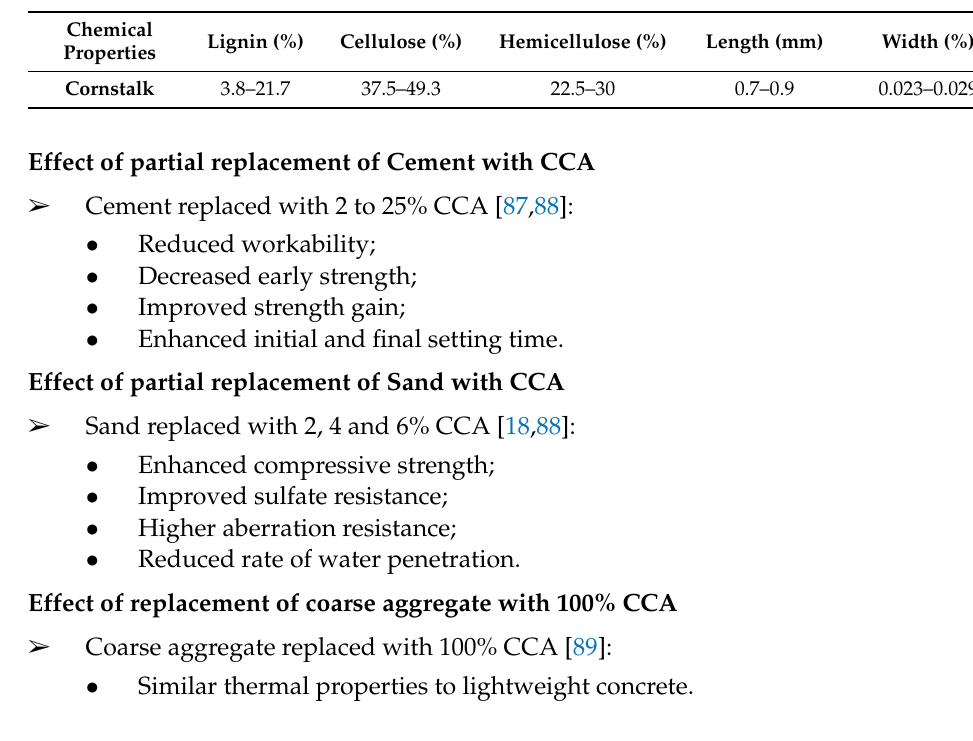
Table 10. Natural fiber chemical and morphological characteristics of Cornstalk